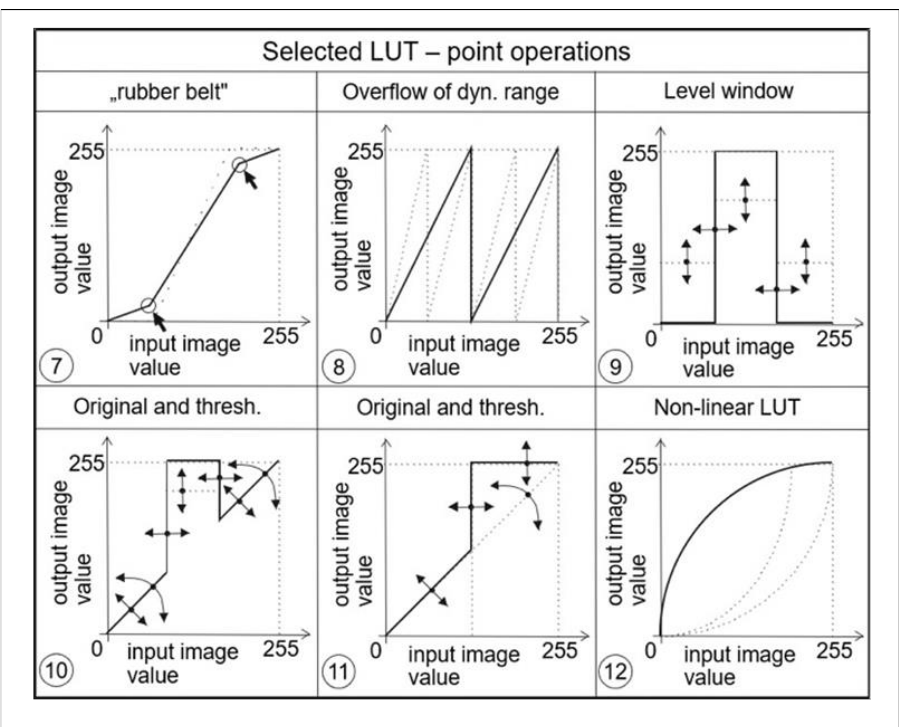
Figure 5. Examples of other point operators (functions) that could also be utilized.